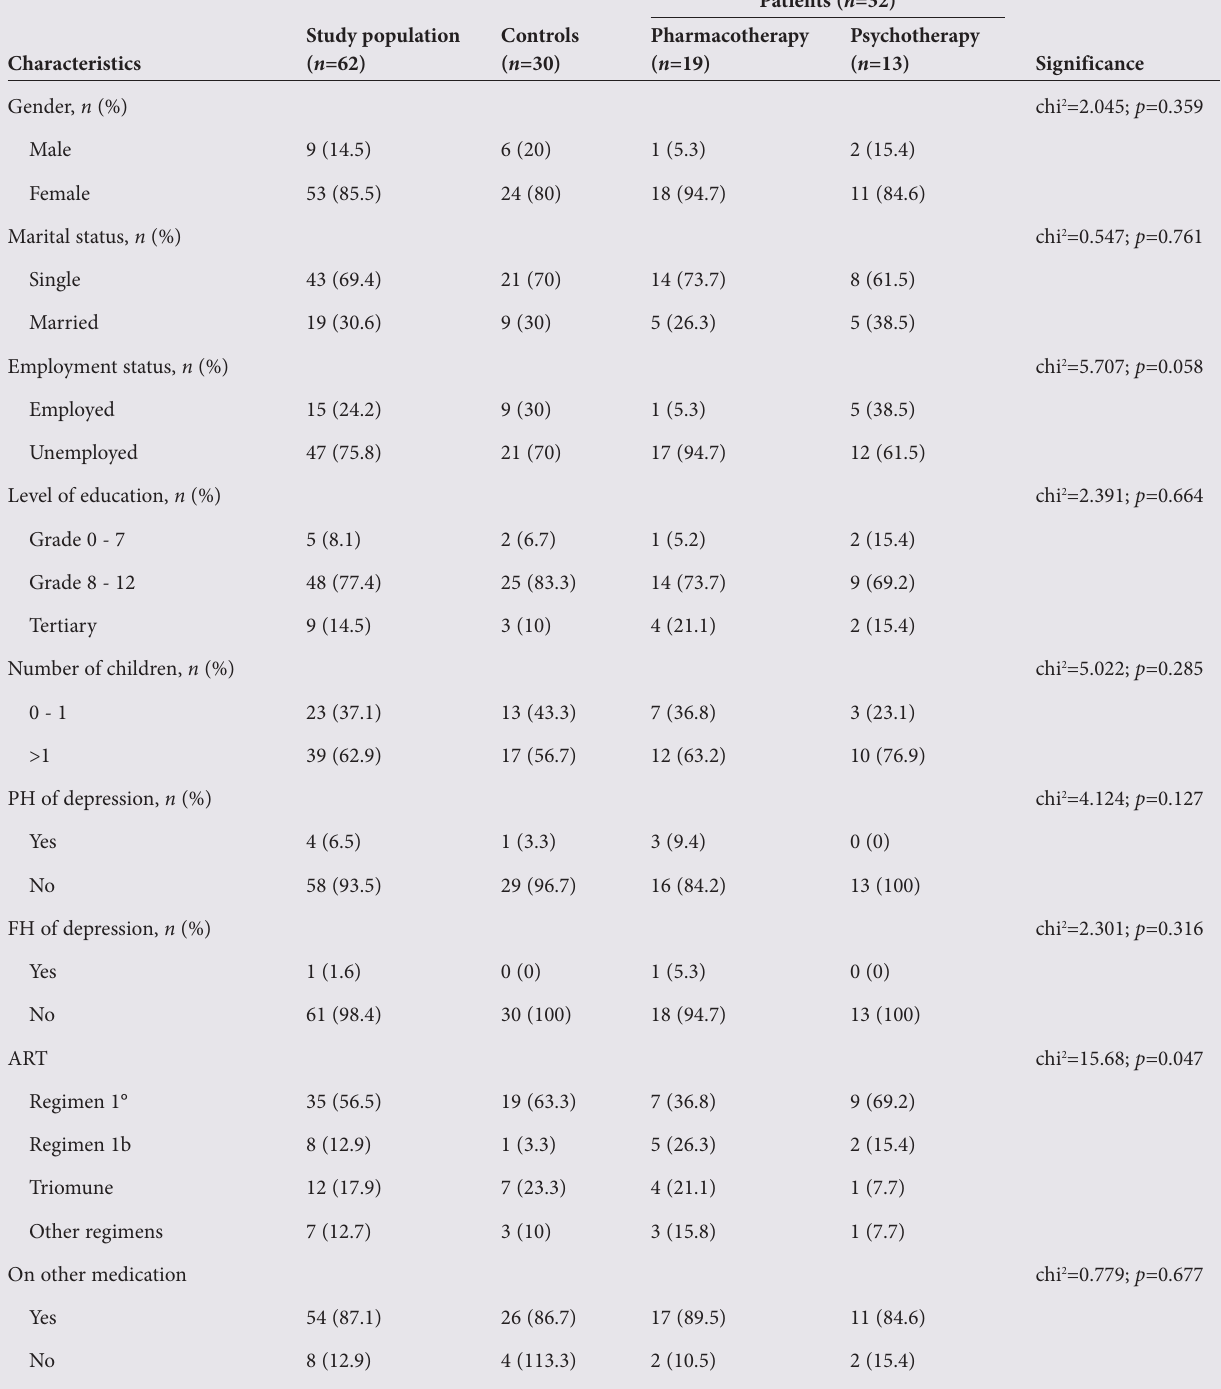
Table 1. Sociodemographic characteristics of the control v. depressed patient groups